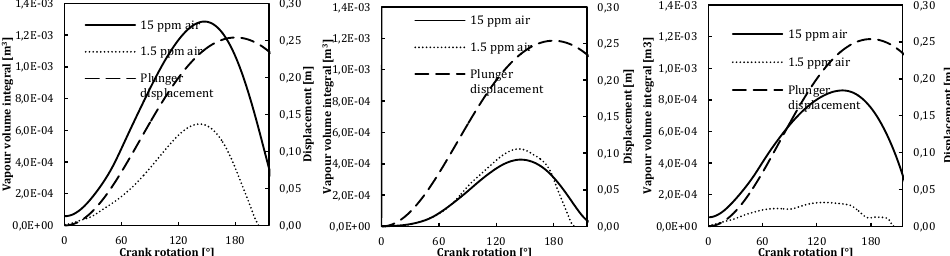
Figure 8: (left) Chamber volume integral of the 2 nd phase (vapour + air), when air mass fraction is 15 ppm (case1) and 1.5 ppm (case2); (mid- dle) Chamber volume integral of vapour; (right) Chamber volume integral of air. Figure 8. (left) Chamber volume integral of the 2nd phase (vapour + air), when air mass fraction is 15 Figure 8. (left) Chamber volume integral of the 2nd phase (vapour + air), when air mass fraction is 15 Figure 9. (left) Chamber volume integral of the second phase components Case number 1, air mass ppm (case1) and 1.5 ppm (case2). (middle) Chamber volume integral of vapour. (right) Chamber fraction 15 ppm. (right) Case number 2, air mass fraction 1.5 ppm. ppm (case1) and 1.5 ppm (case2). (middle) Chamber volume integral of vapour. (right) Chamber volume integral of air. volume integral of air.